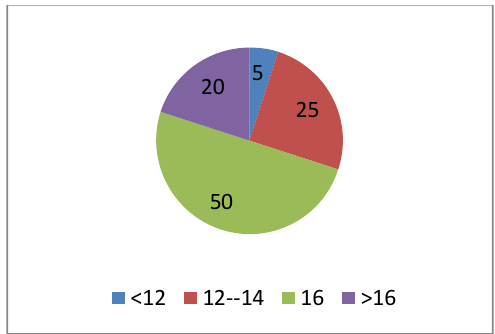
Fig. 1. Personal characteristics of the participants (Years of